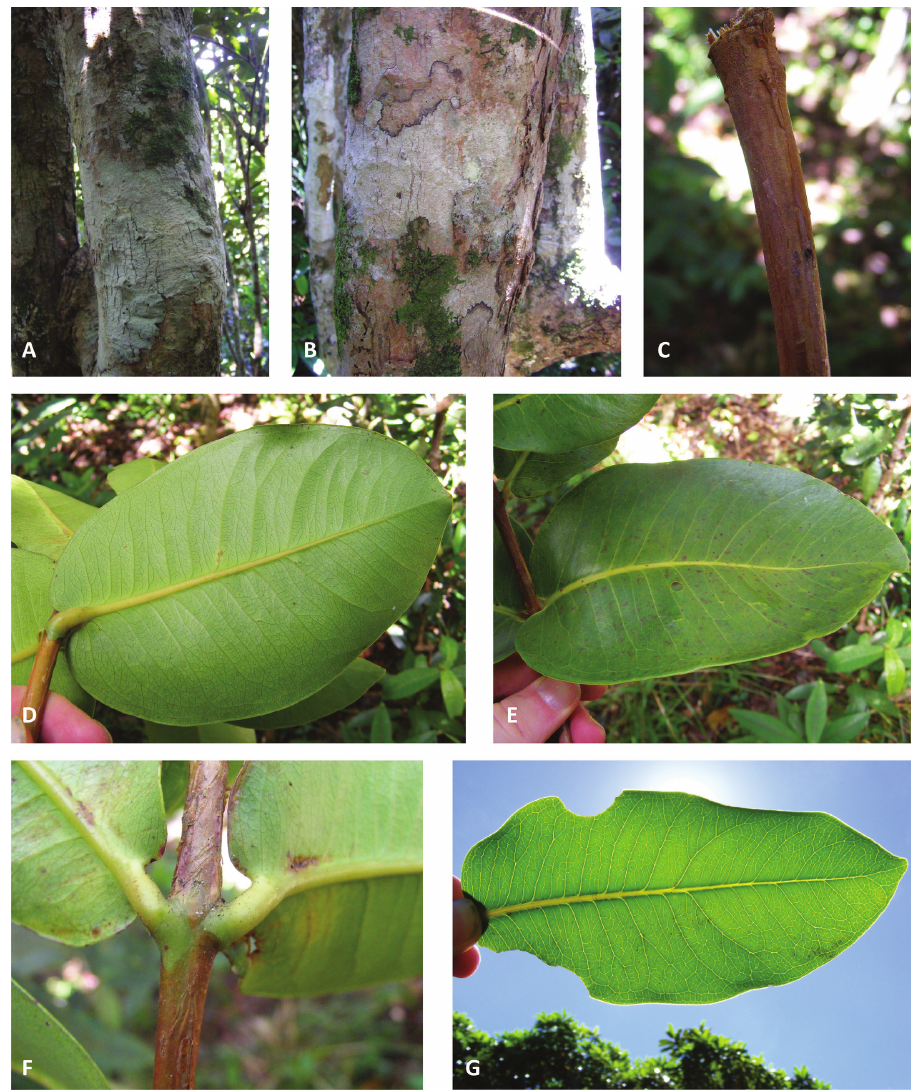
Figure 1. Vegetative characters. A and B bark C close-up of branchlet D lower leaf surface E upper leaf surface F petioles G leaf venation. ( A and G Byng 83; B–F Byng 84).